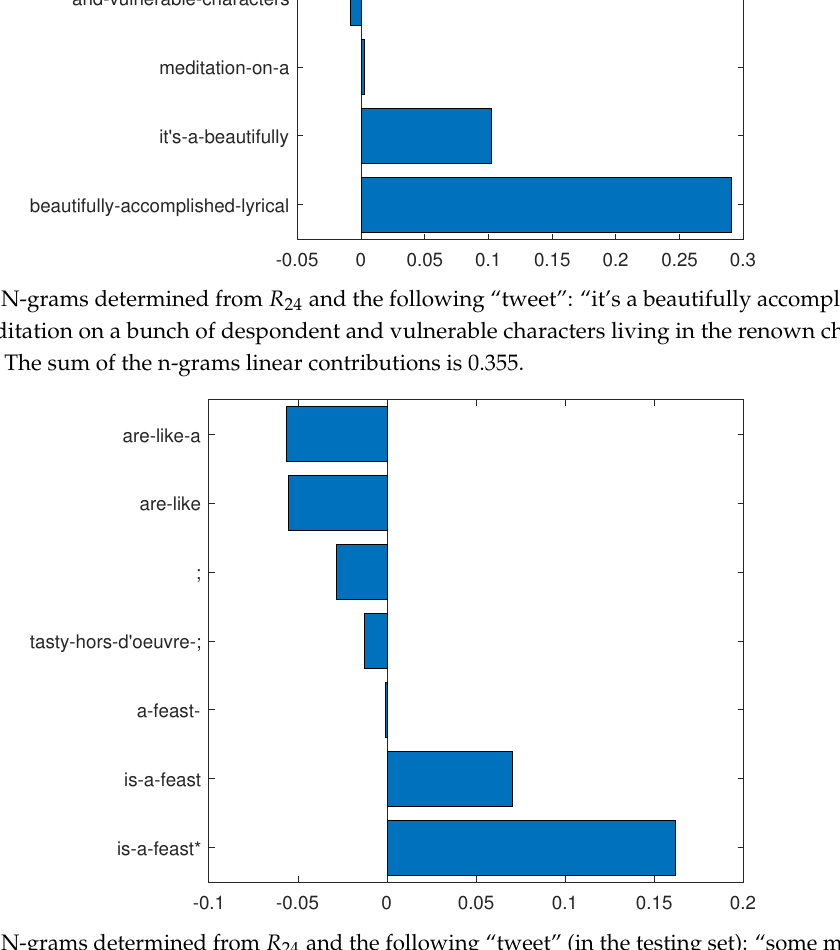
Figure 15. N-grams determined from R 24 and the following “tweet” (in the testing set): “some movies are like a tasty hors-d’oeuvre; this one is a feast”. It is correctly classified by the rule, but wrongly classified by the